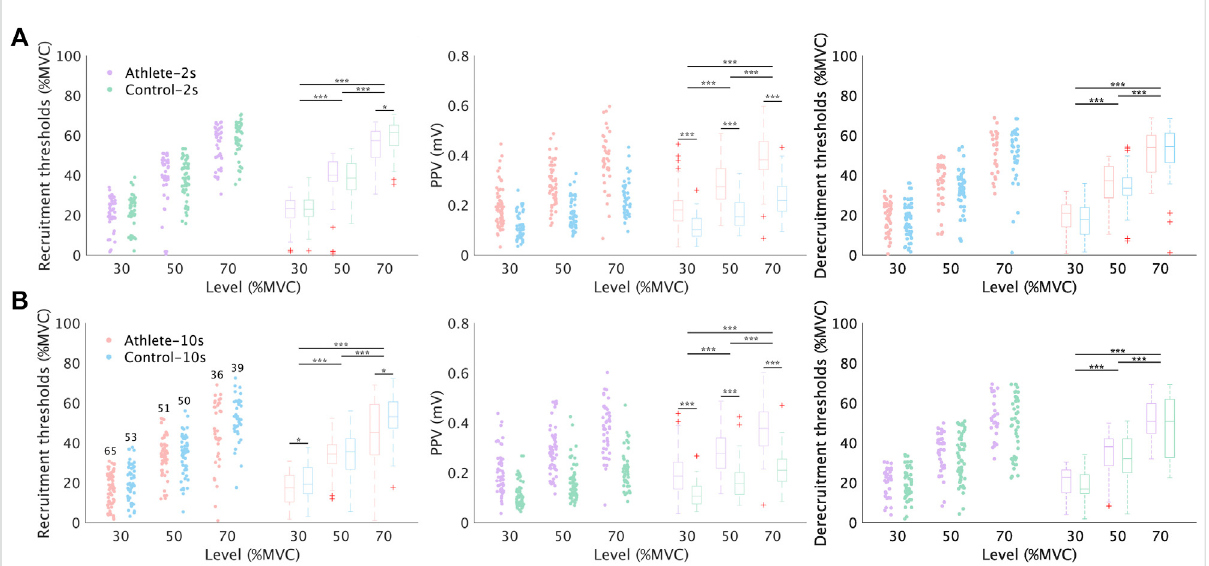
FIGURE 4 Comparison of recruitment threshold, derecruitment threshold, and MUAP amplitudes between Athlete and Control group. (A,B) illustrate the comparison results from session 1 and session 2, respectively. Only the common MUs were analyzed in this fi gure. The number of common MUs is indicated in the left subgraph. The scatters show all the values of each metric, while the box plots show the corresponding statistic distribution. The signi fi cance level of the difference between groups or contraction levels is provided above the box